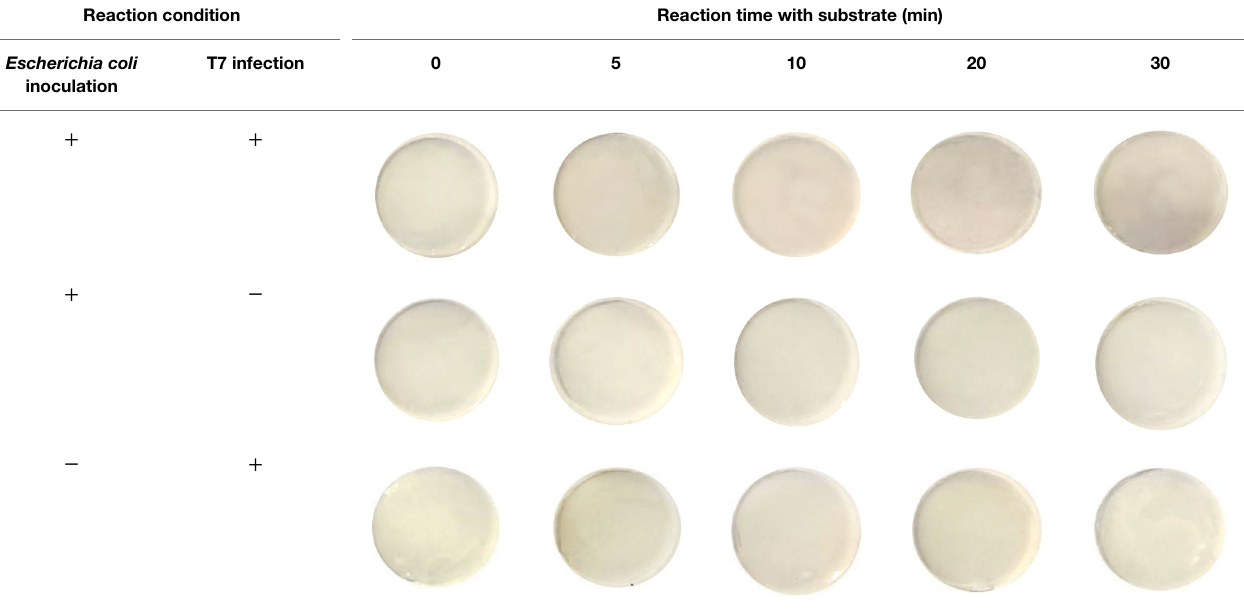
TABLE 1 | Filters with 5-h enriched 10 CFU/ml Escherichia coli BL21 and 30 min with and without infection with bacteriophage T7-ALP in TSB and bacteriophage T7-ALP in TSB after enzymatic reaction with NBT/BCIP for 5, 10, 20, and 30 min. Reaction condition Reaction time with substrate